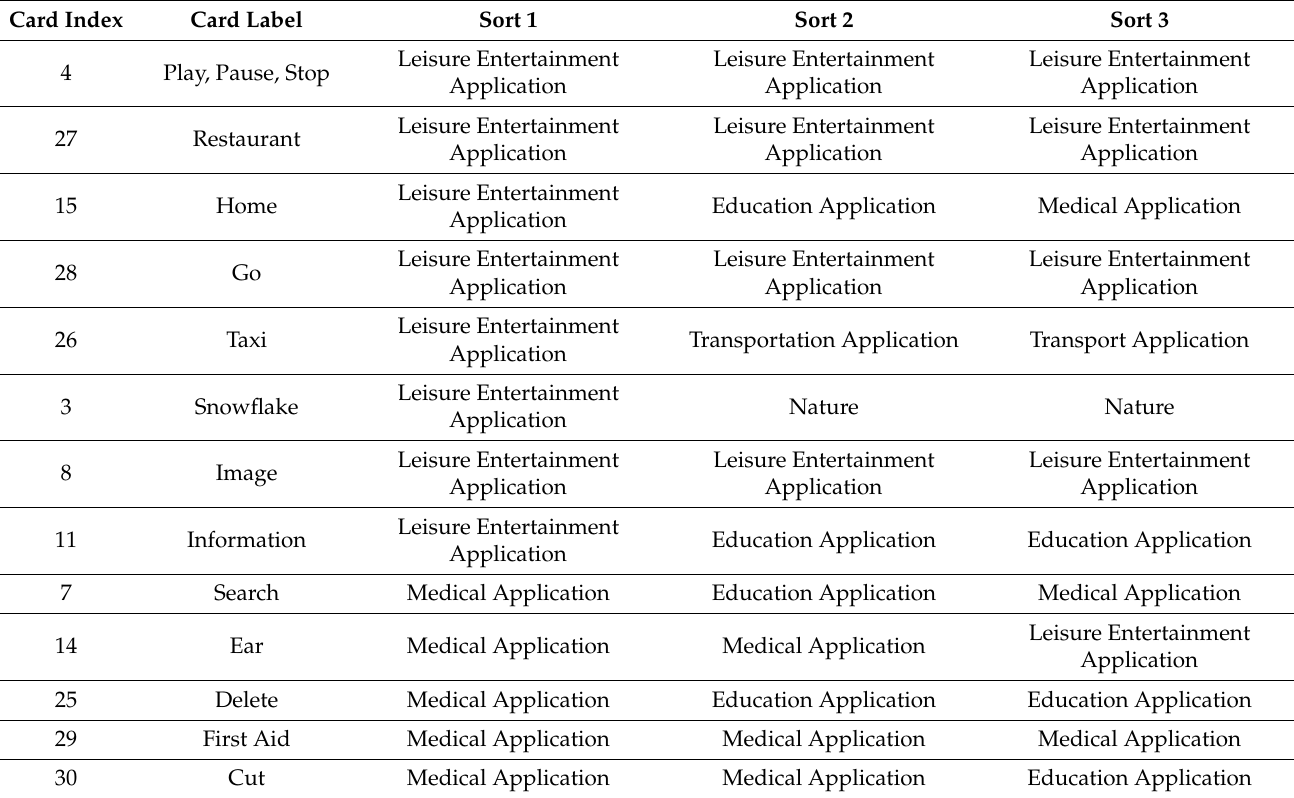
Table A1. Samples of Data Collected from